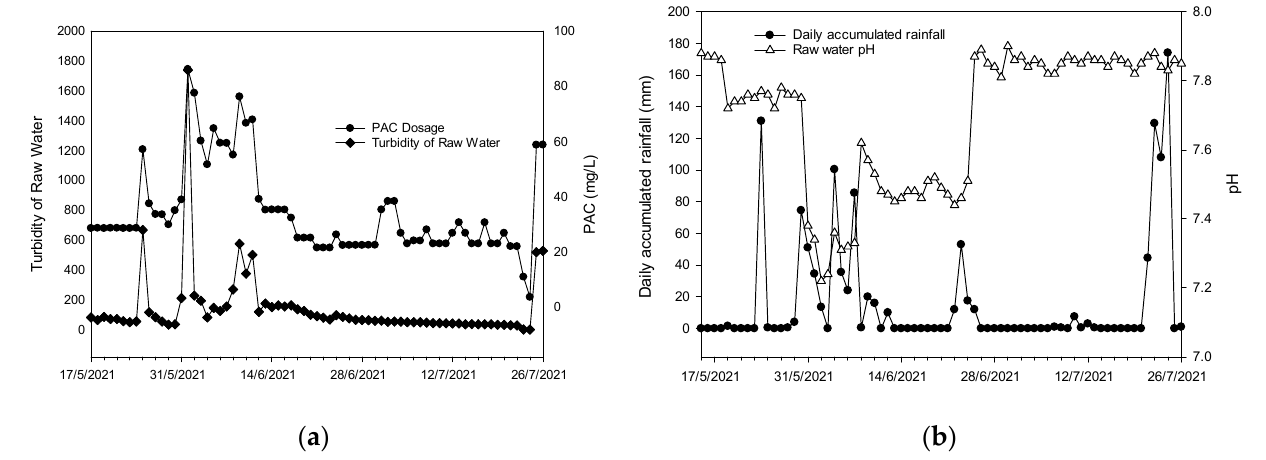
Figure 9. ( a ) Changes in raw-water turbidity and polyaluminum chloride (PAC) dosage and ( b ) cumulative rainfall and raw-water pH on each day.